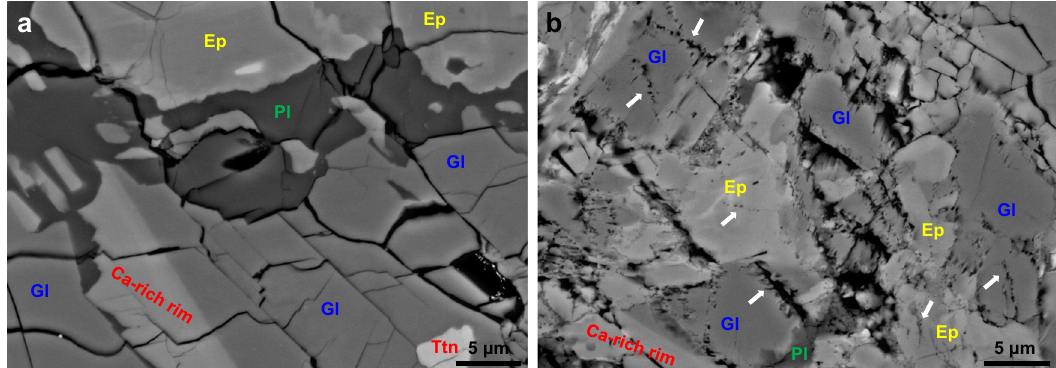
Fig. 3 Experimental product of natural epidote blueschist showing dehydration features of glaucophane. A modi fi ed Griggs apparatus was used for the dehydration of the natural epidote blueschist. Back-scattered electron (BSE) images showing a no dehydration of epidote blueschist after experiment at 2 GPa and 570 ± 10 °C and b partially dehydrated glaucophane (Gl) with rugged grain boundaries and fl uid inclusion trails (white arrows) after experiment at 2 GPa and 730 ± 10 °C; consequently, omphacite (om) has formed as the dehydration product (Supplementary Fig. 7). Phase abbreviations: epidote (Ep), plagioclase (Pl), and titanite